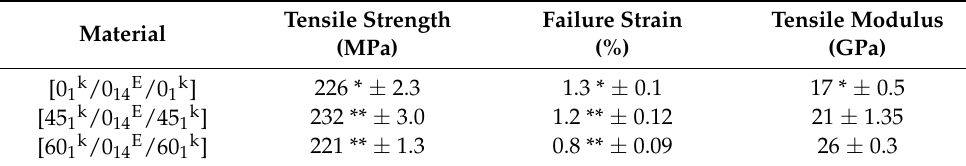
Table 2. Tensile properties for hybrid composites.